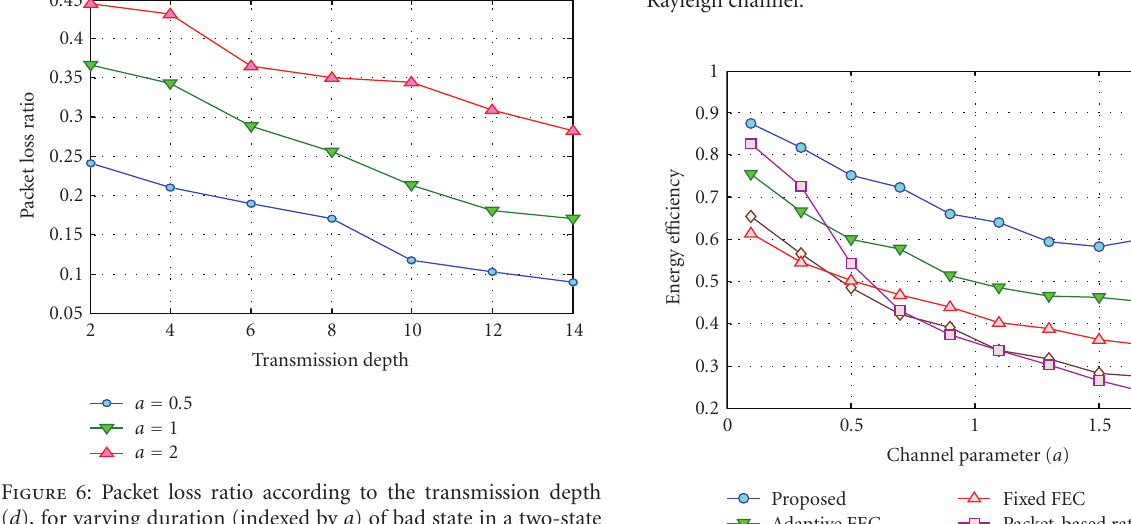
Figure 7: Comparison of packet loss for block-based rateless coding and various FEC-bearing streams with competing biosensor tra ffi c, for varying duration (indexed by a ) of bad state in a two-state Rayleigh channel.